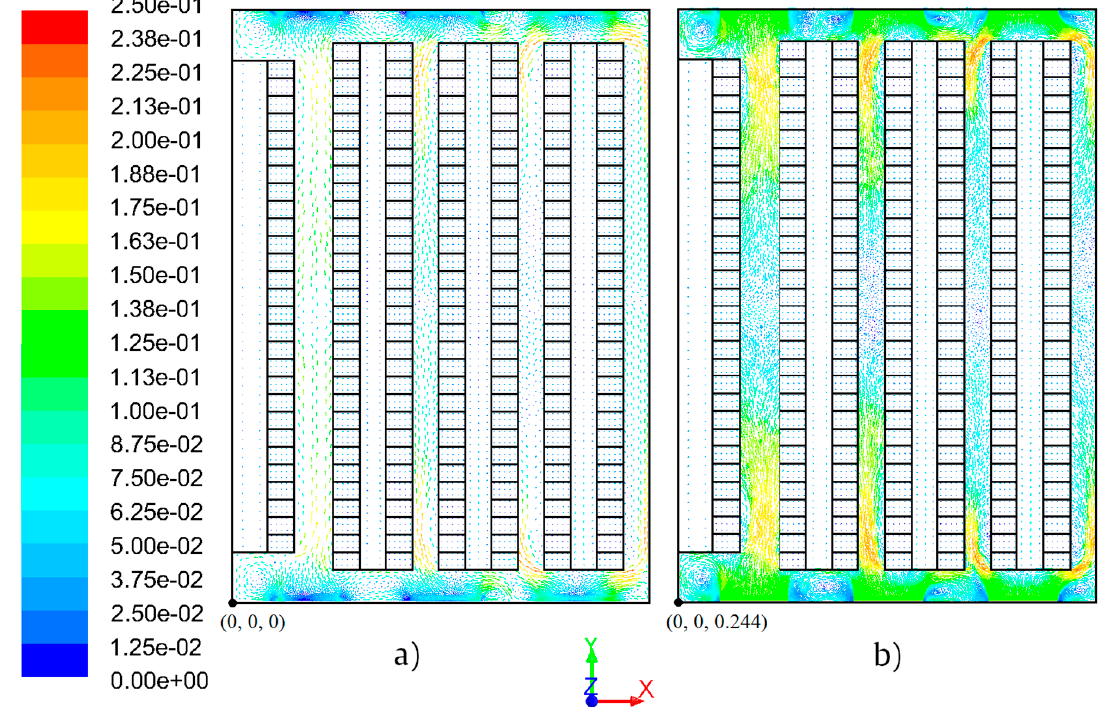
Figure 24. The results of the dimensionless velocity vectors for the minimum air flow velocity in the x–y plane represented through the planes: ( a ) z adm = 0; and ( b ) z adm = 0.244.